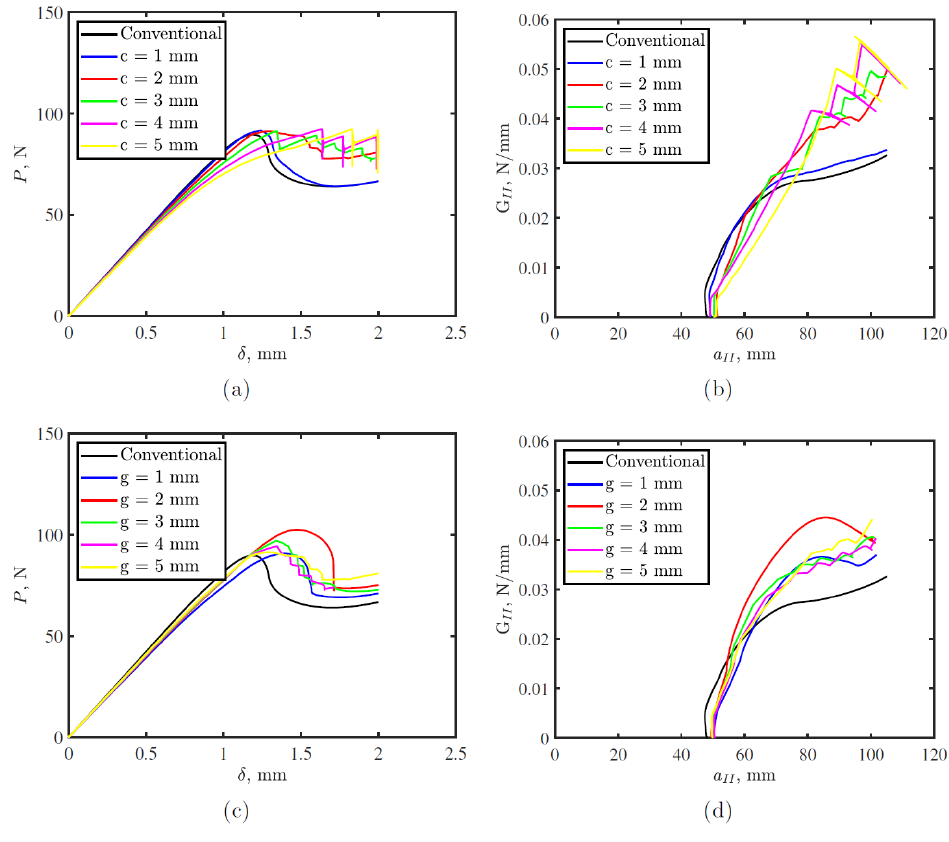
Figure 8. End notch flexural (ENF) simulation crack width, c , and gap between two successive cracks, g , effects on, ( a , c ) load-displacement; and ( b , d ) R-curve,